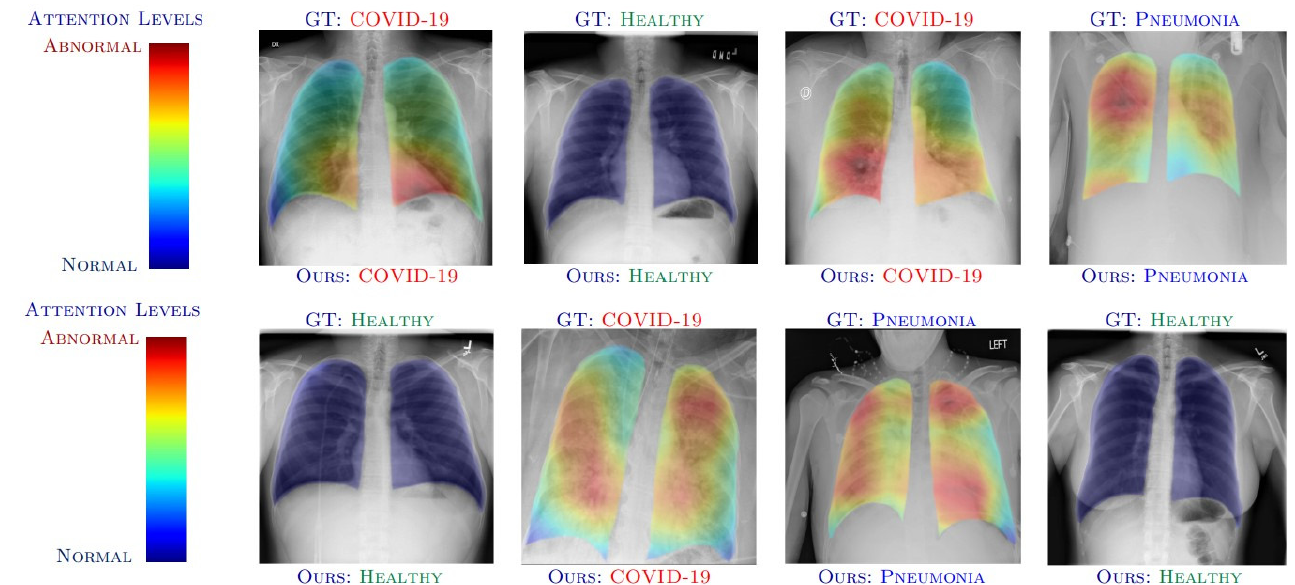
Figure 9. GraphXCovid pneumonia CXR results.